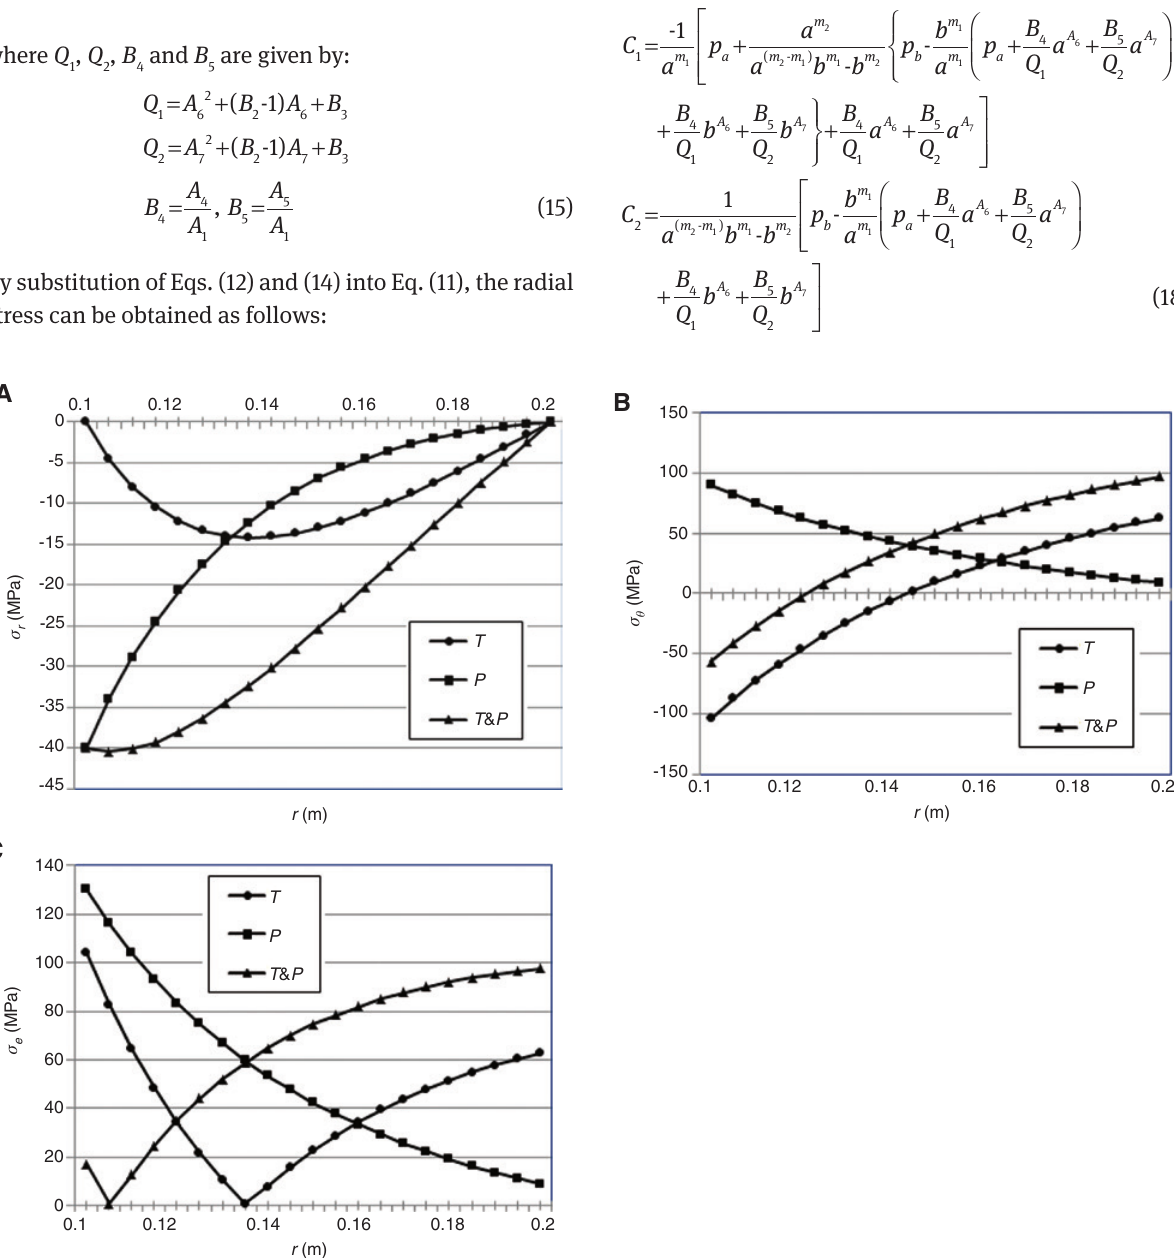
Figure 3: The (A) radial, (B) circumferential and (C) effective stresses in an FG cylinder subjected to pressure, temperature and combined pressure and temperature gradient loadings ( p